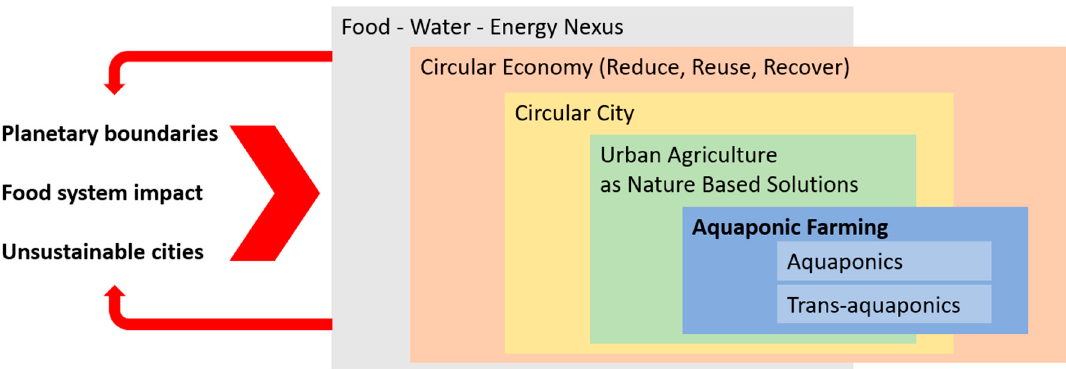
Figure 1. Different methodological approaches that can be applied to solve global problems; boxes indicate set relations.